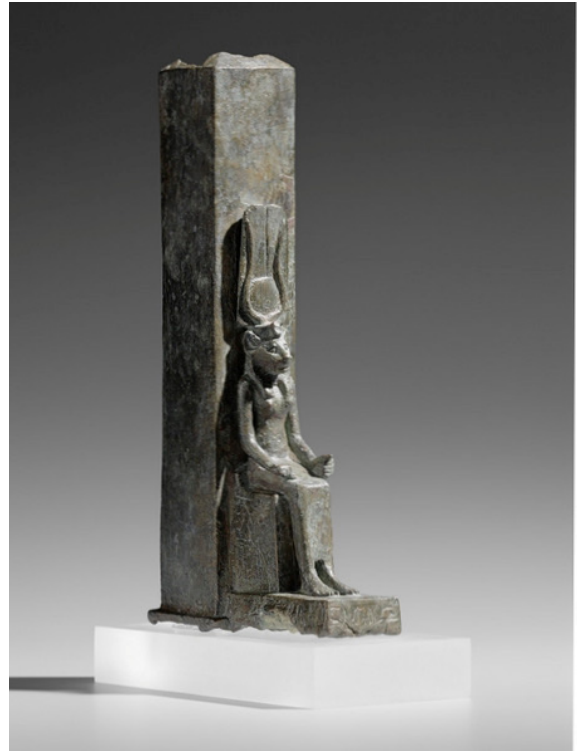
Figure 7. A bronze reliquary for an ichneumon inscribed for the Egyptian goddess Wadjet. Berlin, Ägyptisches Museum und Papyrussamlung, Staatliche Museen 13142. ©Foto: Ägyptisches Museum und Papyrussamlung, Staatliche Museen zu Berlin Fotografin: Sandra Steiss. SMB-digital is